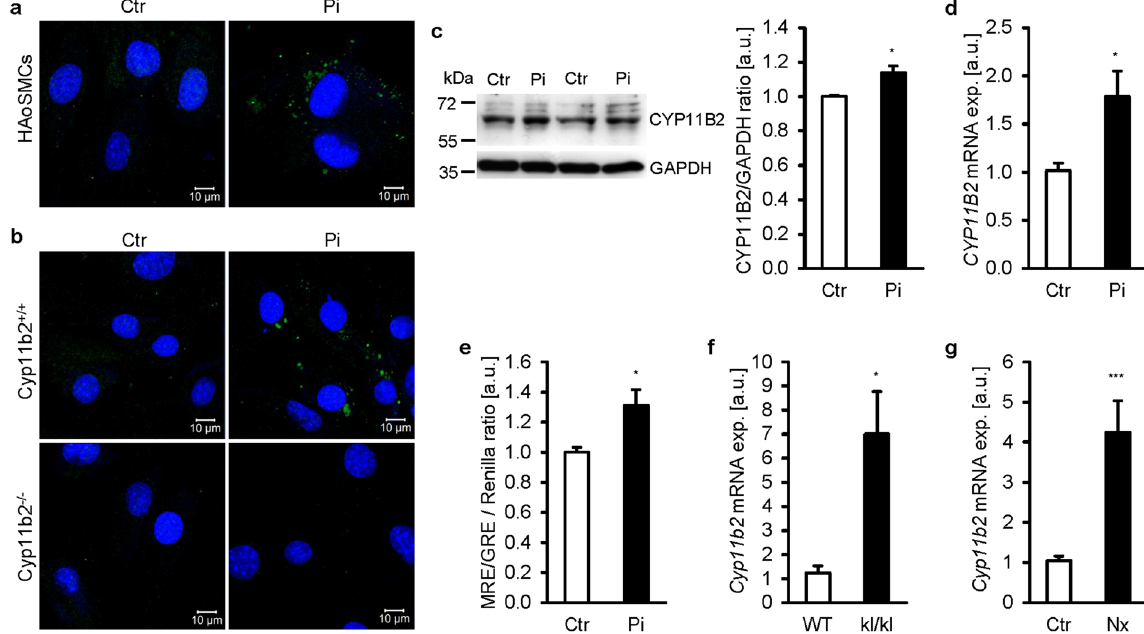
Figure 2. Phosphate induces aldosterone synthase expression in VSMCs. Representative confocal microscopy images showing aldosterone synthase (CYP11B2) protein expression in HAoSMCs ( a ) and in MAoSMCs isolated from aldosterone synthase-deficient mice (Cyp11b2 − / − ) or corresponding wild-type mice (Cyp11b2 + / + ) ( b ) following treatment for 24 hours with (Pi) or without (Ctr) phosphate. Images are representative for four independent experiments. CYP11B2 expression: green labeling, nuclei: blue labeling. Scale bar: 10 μ m. ( c ) Representative original Western blots and arithmetic means ± SEM (n = 4; arbitrary units, a.u.) of normalized CYP11B2/GAPDH protein ratio in HAoSMCs following treatment for 24 hours with (Pi) or without (Ctr) phosphate. Arithmetic means ± SEM of CYP11B2 relative mRNA expression ( d , n = 6; a.u.) and MRE/GRE- dependent transcriptional activity measured by luciferase reporter assay ( e , n = 6; a.u.) in HAoSMCs following treatment for 24 hours with (Pi) or without (Ctr) phosphate. Arithmetic means ± SEM (a.u.) of Cyp11b2 relative mRNA expression in aortic tissue from kl/kl mice and corresponding wild-type mice (WT)( f , n = 8) and from DBA mice without (CTR) or with subtotal nephrectomy (Nx) ( g , n = 8). * (p < 0.05) statistically significant vs. control treated HAoSMCs, WT mice or control treated mice,